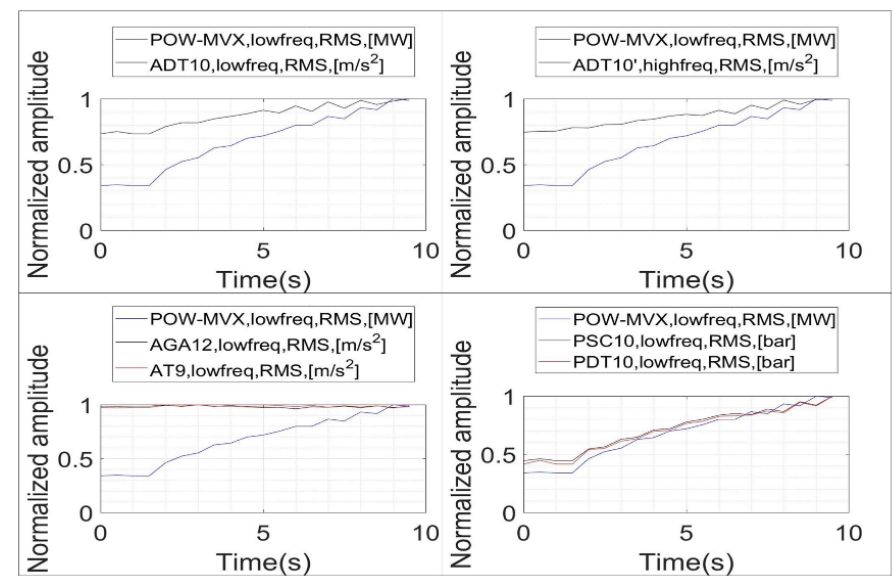
Figure 11. Evolution of the RMS indicators during the onset of the instability ( x RMS − power vs. x RMS ).